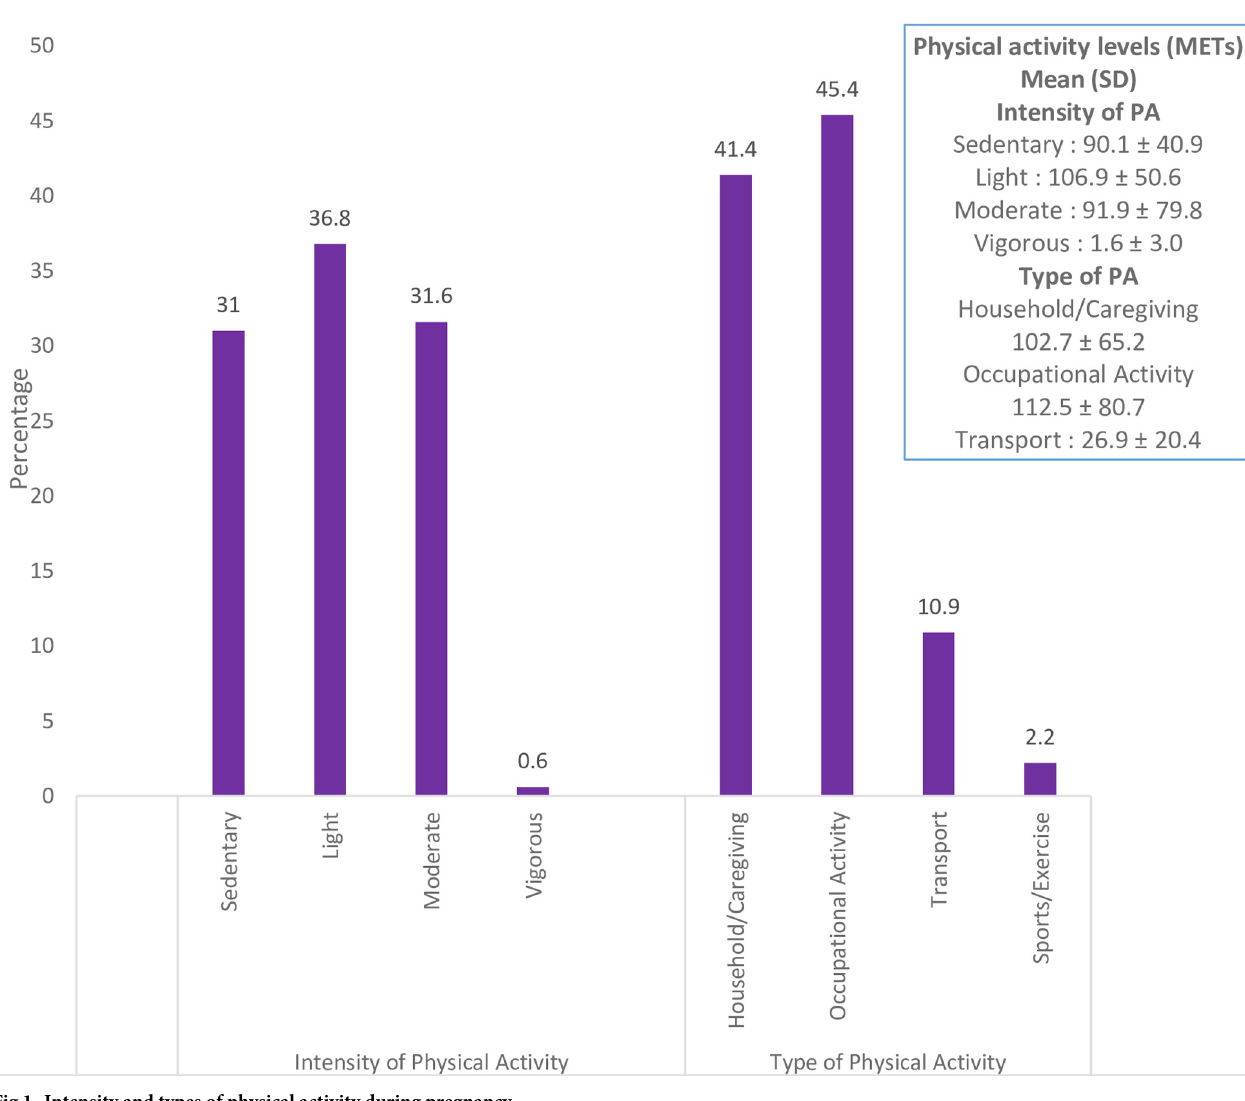
91.9 ± 79.8 MET-h/week, and vigorous activity was rare (0.6%). The pattern of energy expen- diture was: occupation-related activity (45.4%), household/caregiving activities (41.4%), and transport-related (10.9%), while sports or exercise were infrequent (2.2%). Fig 2 displays a box- plot that shows the duration of moderate-intensity activity per week in minutes by pregnant women. The mean duration was 26.3 ± 22.9 minutes. None of the individuals in the study met